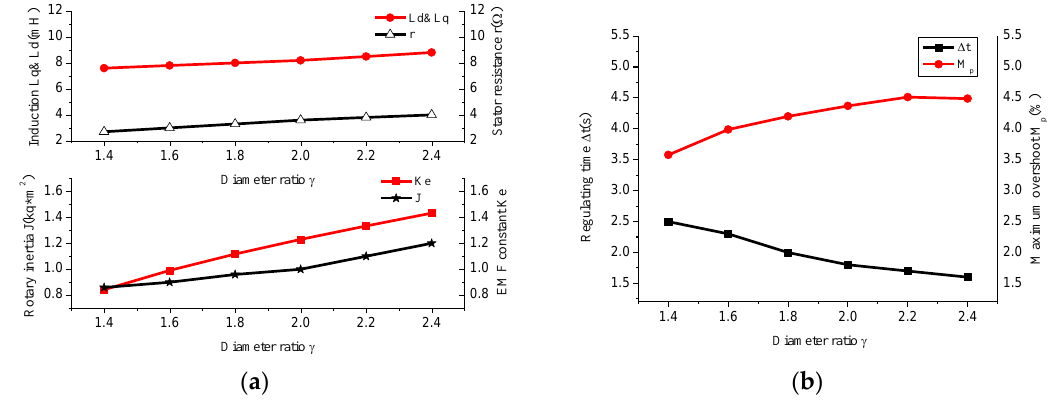
Figure 8. Influence of different diameter ratio: ( a ) Model variables; ( b ) Dynamic characteristic response.